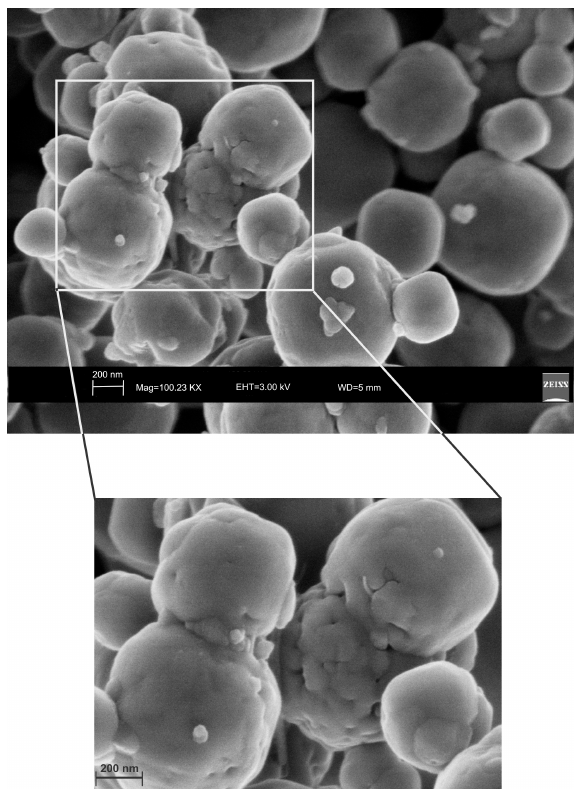
Figure 9. SEM images of sample 12 months after the synthesis by HY. They show isolated LTA crystal affected by an initial process of transformation into sodalite.